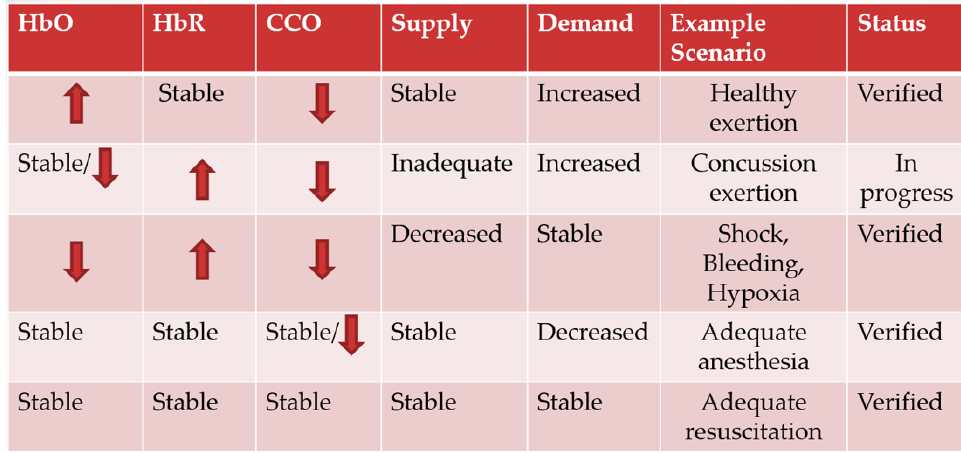
Figure 33. Expected behavior of CCO, HbO, and HbR in various physiological states.